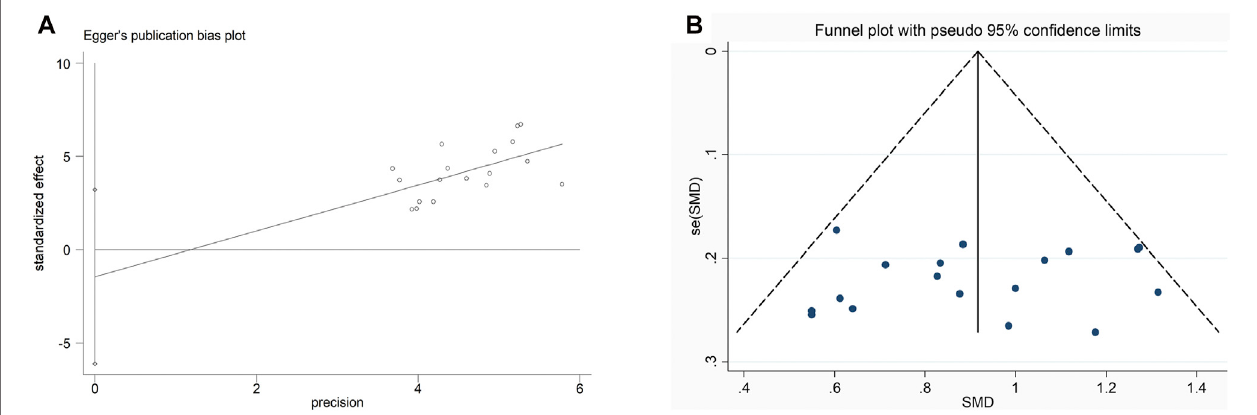
FIGURE 8 | Funnel plot and Egger ’ s test of BMD at lumbar